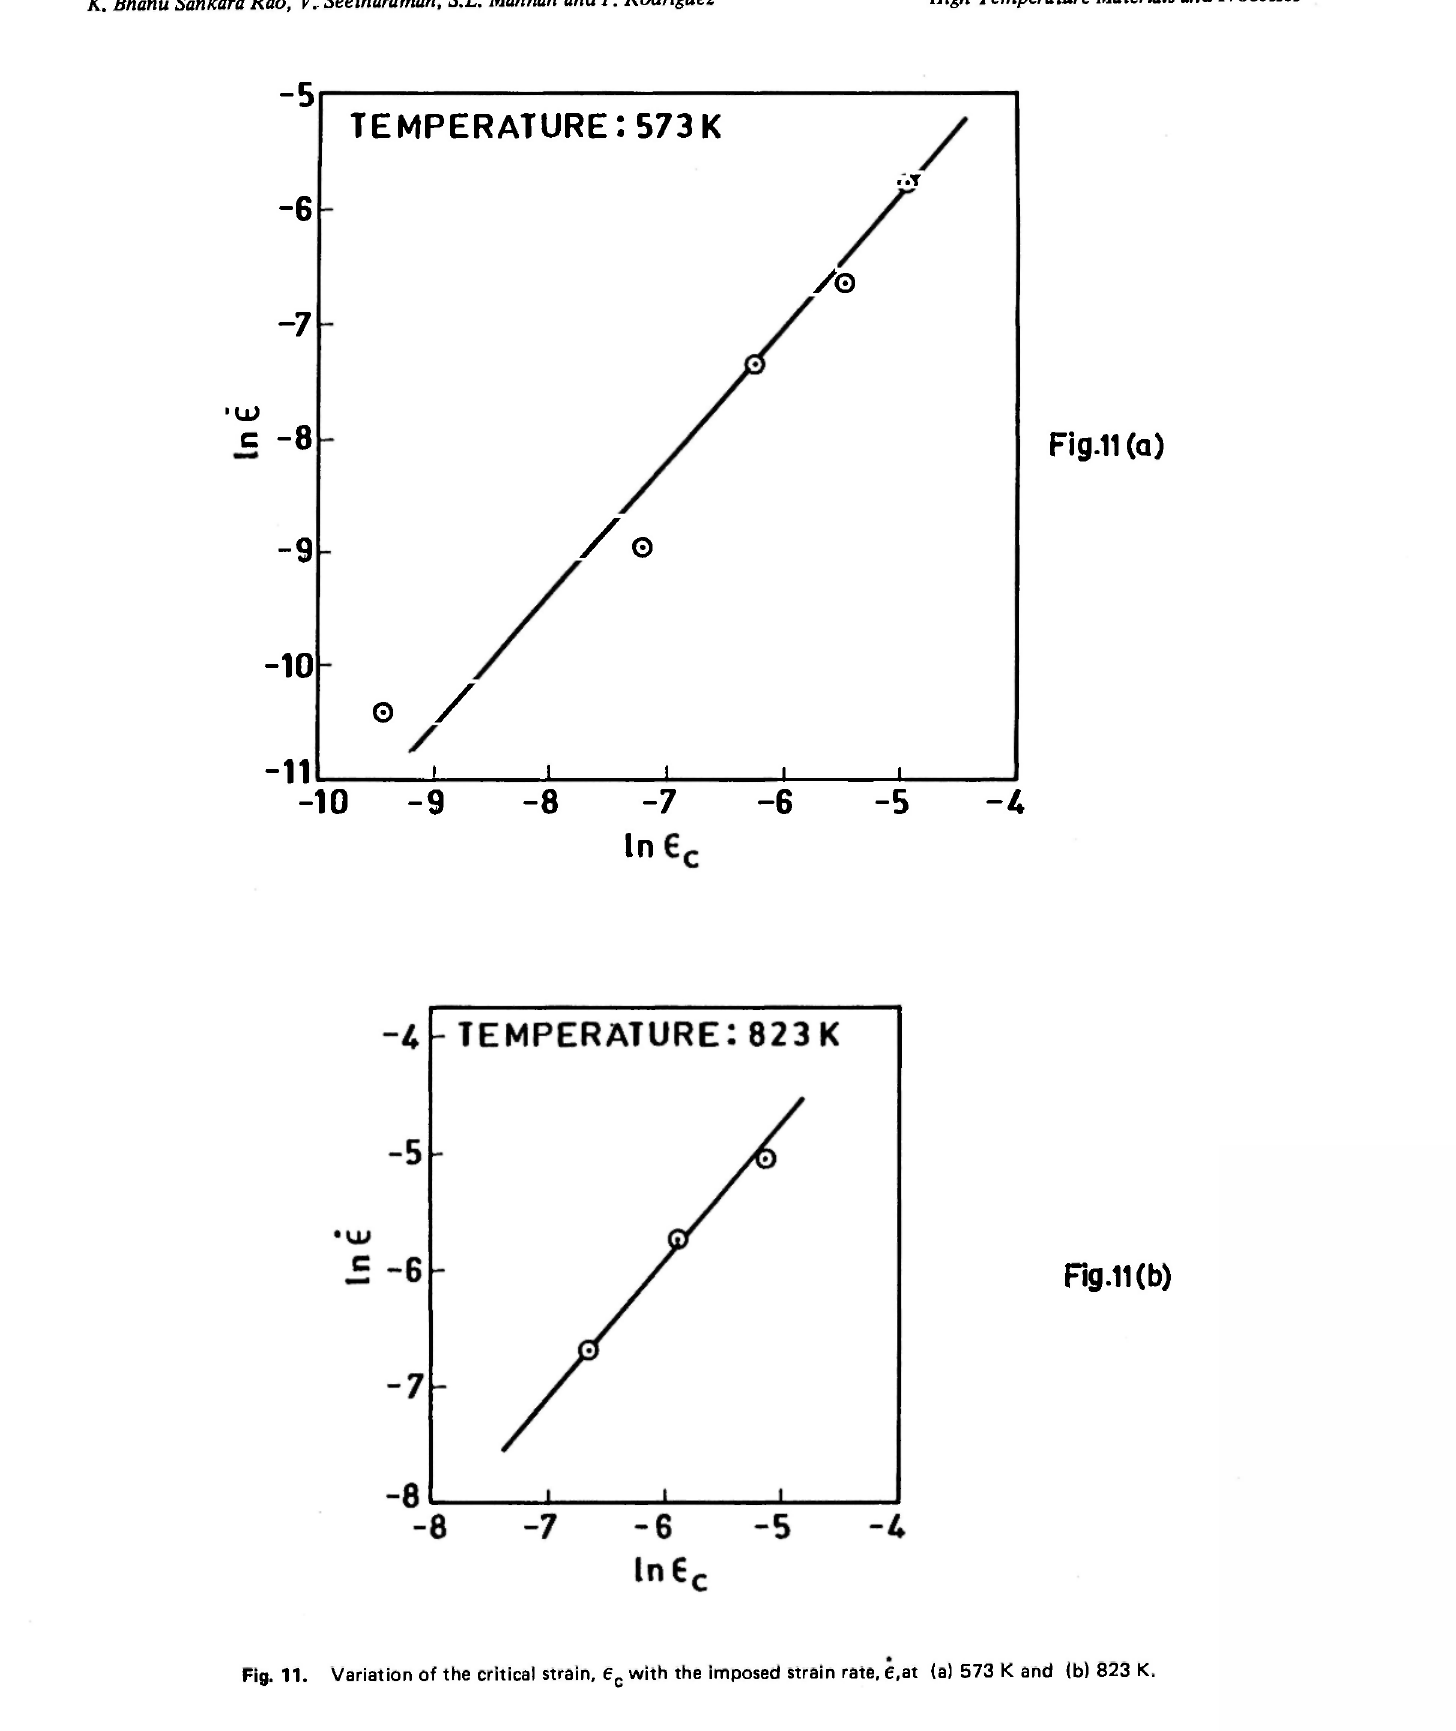
Fig. 11. Variation of the critical strain, e c with the imposed strain rate, e,at (a) 573 Κ and (b) 823